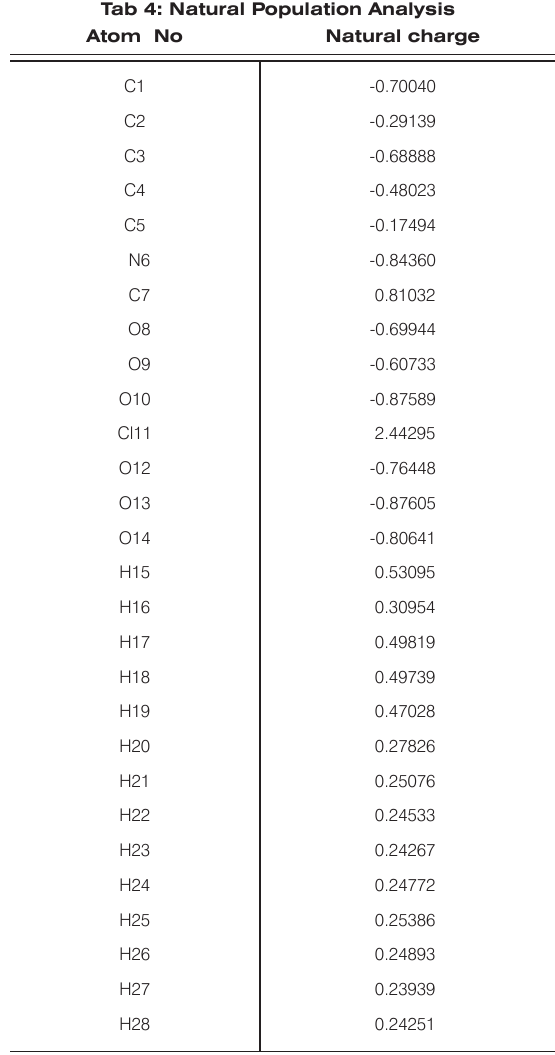
Table 2. Natural Population Analysis. Tab 4: Natural Population